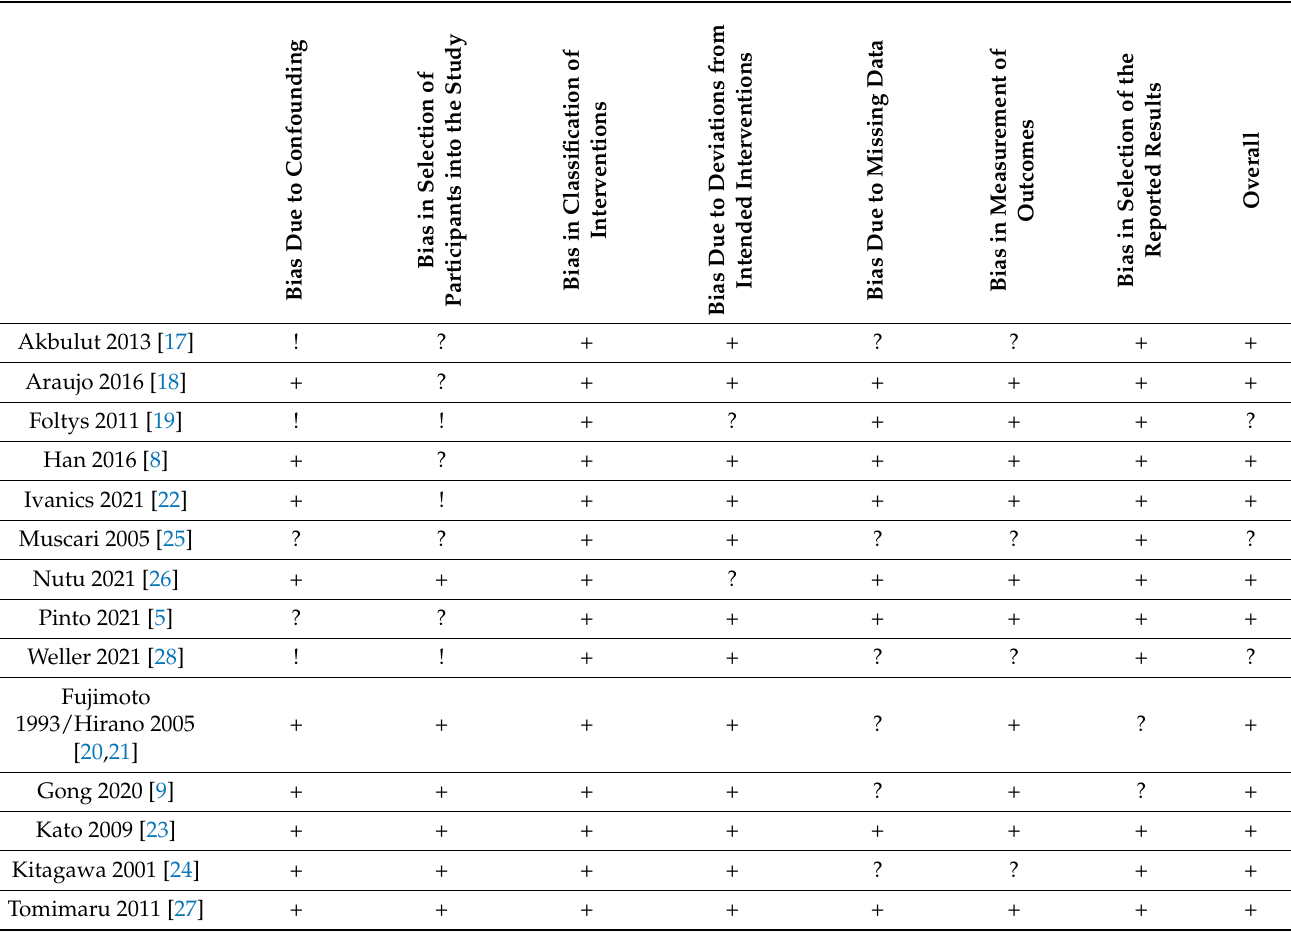
Table 4. Risk of bias of included studies.